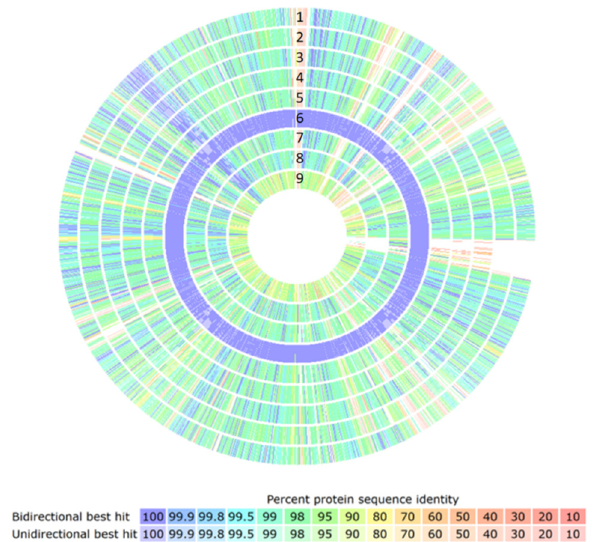
Figure 3. Comparison of protein identity in % of L. johnsonii and L. gasseri strains using CNCM I-4884 as reference. 1, L. johnsonii UMNLJ22; 2, L. johnsonii N6.2; 3, L. johnsonii FI9785; 4, L. johnsonii DPC 6026; 5, L. johnsonii BS15; 6, L. johnsonii ATCC 33200; 7, L. johnsonii NCC 533, 8, L. johnsonii UMNLJ21; 9, L. gasseri ATCC 33323. The red bar represents 10% identity and the blue bar represents 100%.